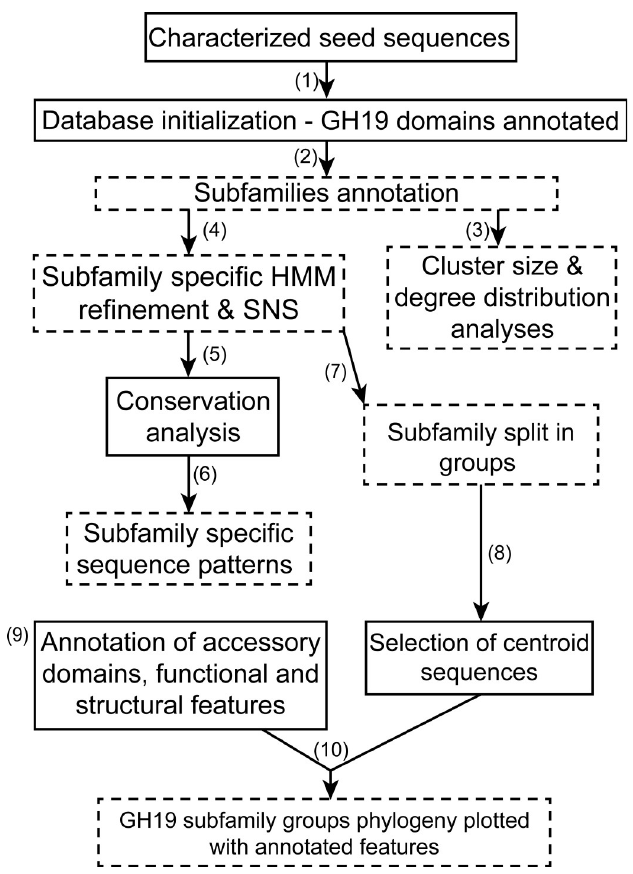
Fig 1. The flowchart of the workflow employed in this work for the analysis of sequence diversity and evolution of the GH19 family. Initially, CAZy and literature screenings were employed to identify the characterized seed sequences. BLAST searches of all seed sequences were conducted and sequences shorter than 120 amino acids were removed. The obtained matches were used to create the GH19ED database, in which the GH19 catalytic domain was annotated with an available profile hidden Markov model (HMM) from the Pfam database (1). Then, catalytic domain sequence networks were obtained by all-vs.-all pairwise aligned sequences and a threshold of 40% identity (2) that permitted to identify subfamilies containing enzymes specialized in one type of activity. Subfamilies were annotated in the database. The properties of the GH19 domain sequence space were also investigated by the analysis of network properties obtained at varying identity thresholds (3). Then, a representative sequence was defined for each subfamily, and an alignment with other characterized members (4) was used for new profile HMMs, to define a standard numbering scheme (SNS) to identify homologous sites within each subfamily. An independent evolutionary conservation analysis with Rate4Site was done for each subfamily (5); by aligning the sequences and structures of the most conserved sites between subfamilies (6), sequence patters specific for each subfamily were identified. Each subfamily was further split into groups from catalytic domain sequence networks, by choosing a 60% identity threshold (7) and these groups were annotated in the database. By functional and structural motifs defined in literature and profile HMMs available for accessory binding modules (8), other annotations were inserted into the database In the final step, GH19 catalytic domain sequences from each group were clustered to select representative centroids (9) to build a large-scale phylogeny, in order to investigate the evolution of structural features, previously annotated and extracted from the database (10). The panels with a dashed outline represent results generated in this study. � Structural information in this study refers to chitinase loops, the endolysin 3-helix peptidoglycan binding bundle and accessory binding